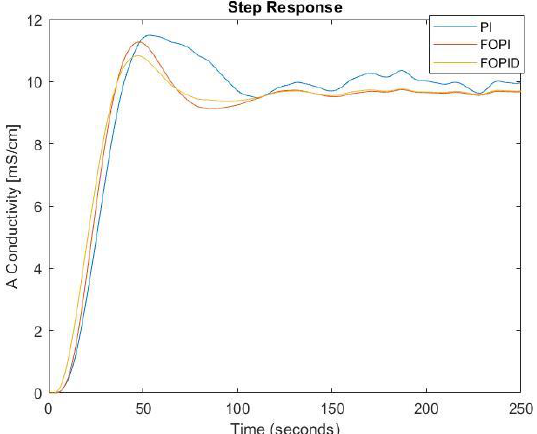
Figure 20. Step responses of the closed-loop system for the integer-order PI, FO-PI, and FO-PID controllers in the case of priming sequences.